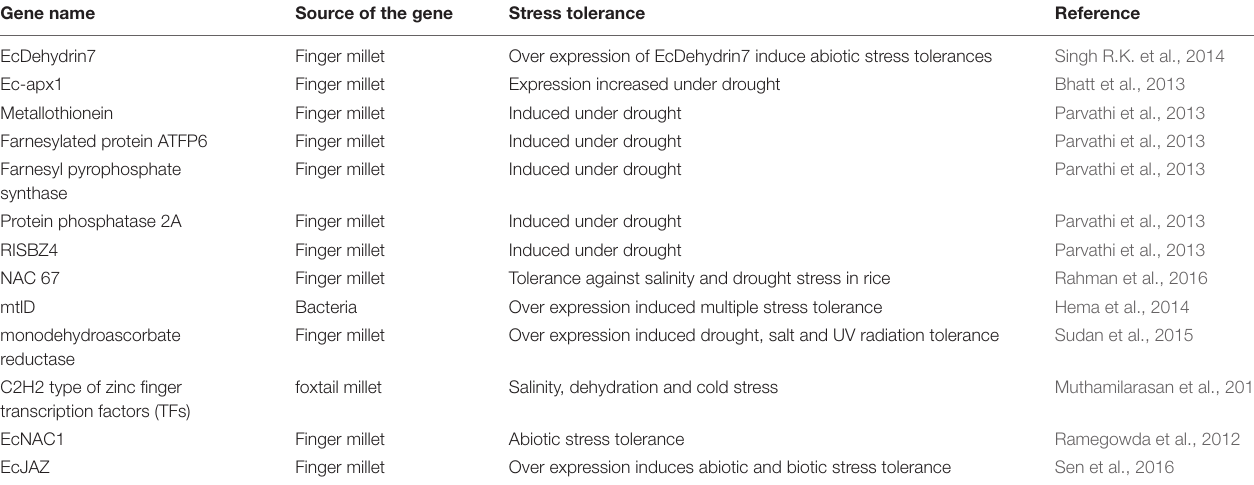
TABLE 2 | Genetic manipulations for improving abiotic and biotic stress tolerance in finger